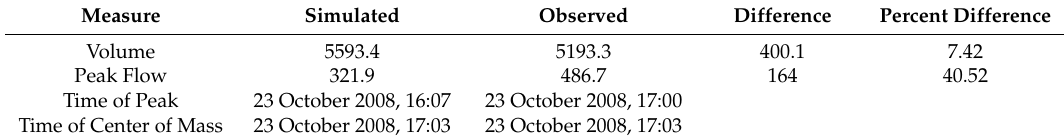
Table 5. Values of the simulated and the observed peak discharge of the studied